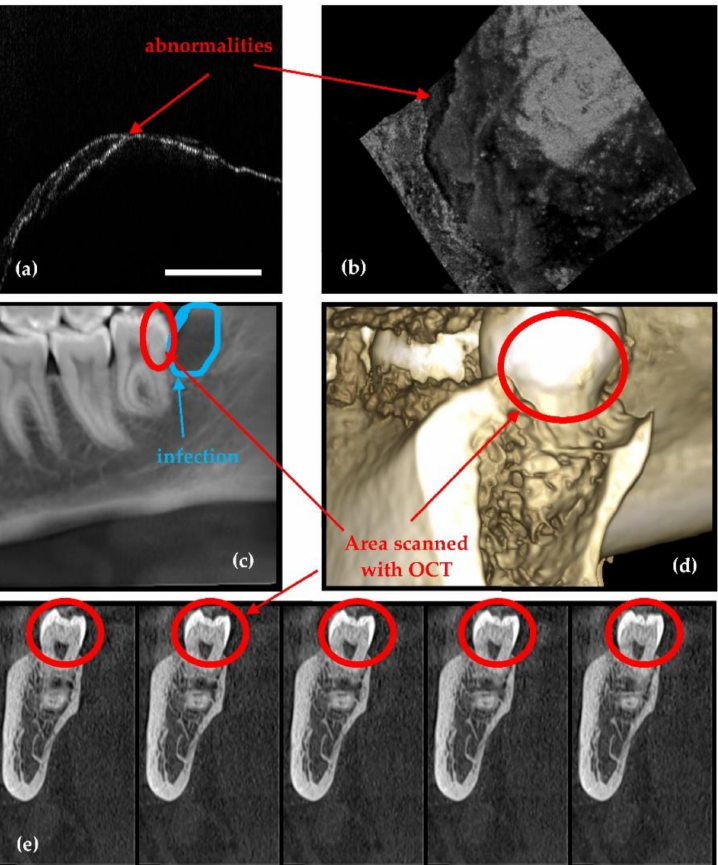
Figure 6. Example where OCT spots abnormalities on the enamel and dentine level of the tooth. ( a ) OCT B-scan; ( b ) OCT 3D reconstruction; ( c ) 3D CBCT axial view of the tooth; ( d ) 3D rendering of CBCT; ( e ) 3D CBCT sagittal view of the tooth (the latter taken at different, successive depths into the hard tissue). Scale: 1